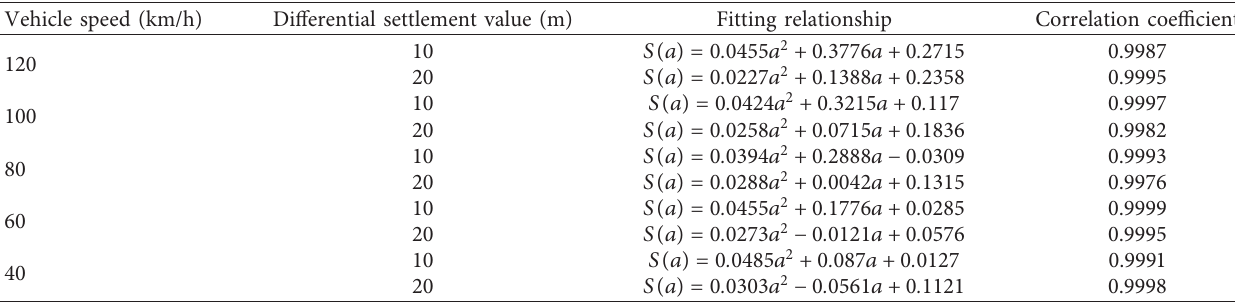
Table 8: Correlation between maximum vertical acceleration and differential settlement value.